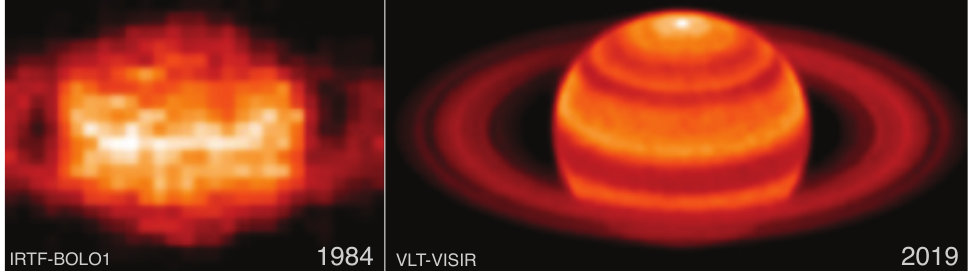
Figure 8. Improvements in mid-IR imaging, as illustrated by an early image of Saturn acquired with the IRTF-BOLO1 instrument in 1984 (left) compared to a recent image from the VLT-VISIR instrument in 2019